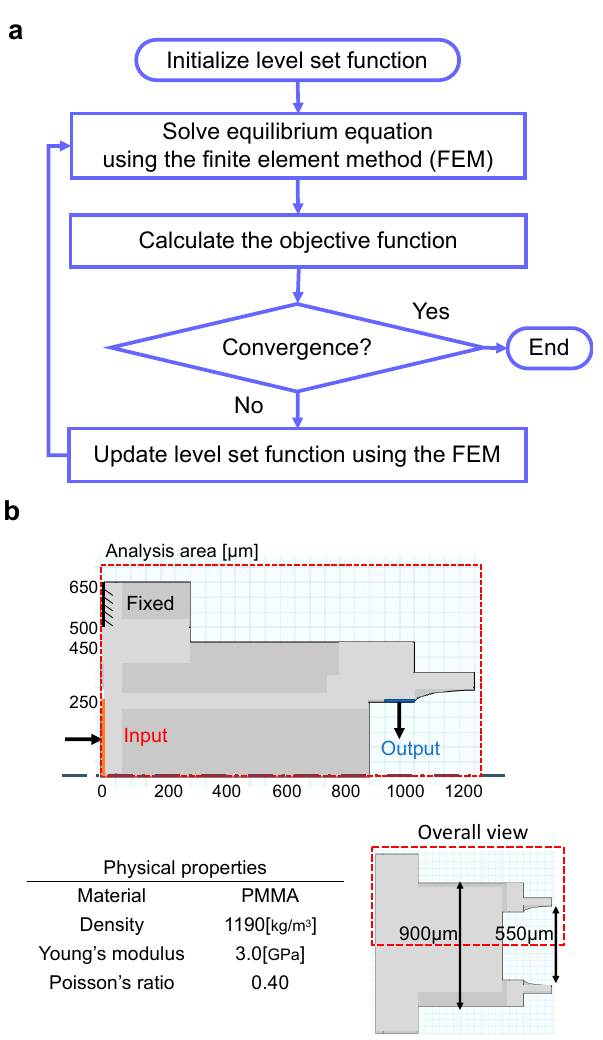
Figure 1. Outline of the topology optimization method and design conditions: ( a ) Flowchart of the algorithm used for topology optimization; ( b ) design conditions and physical properties.